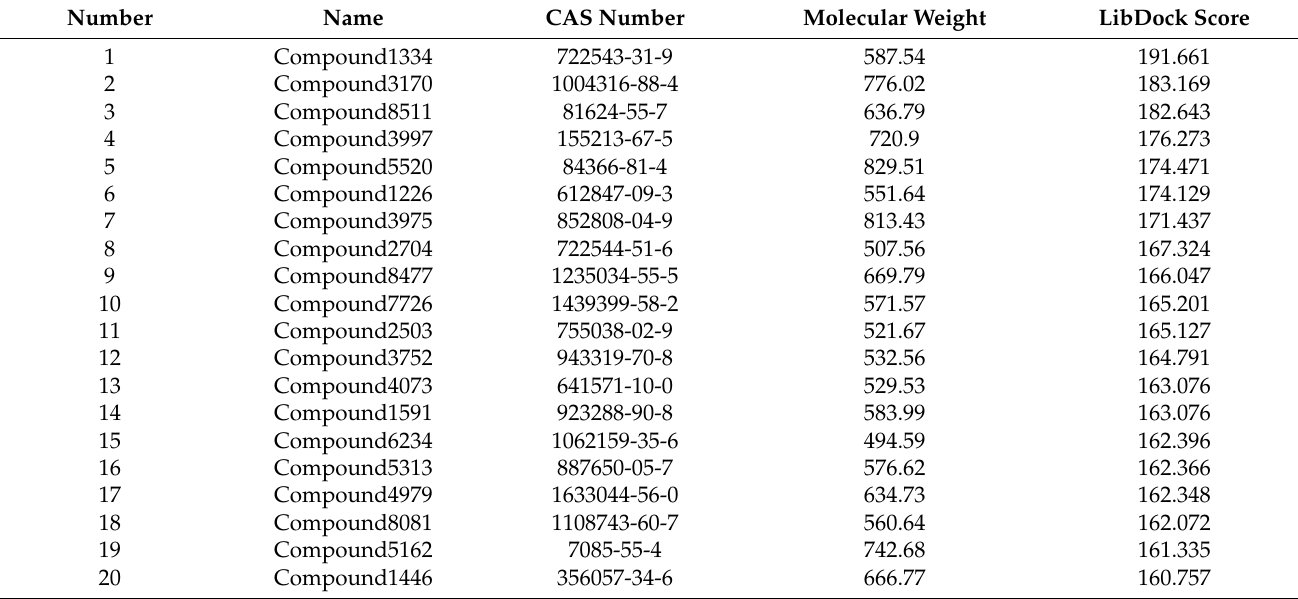
Table 1. Top 20 ranked compounds with higher